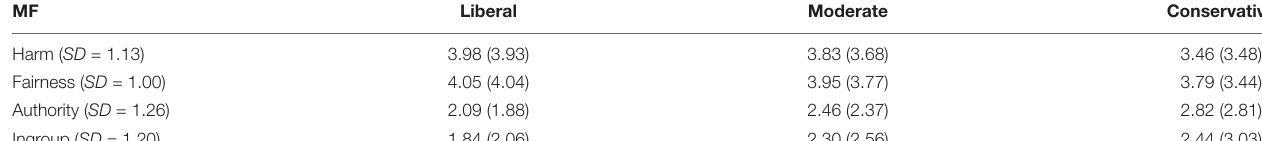
N covid indicates the number of participants who completed the COVID-19 specific block of items at time 2. TABLE 2 | Mean relevance scores for different moral foundations among liberals, moderates, and conservatives, with corresponding mean values from Graham et al. (2011) within parentheses. MF Liberal Moderate Conservative Harm ( SD = 1.13) Authority ( SD = 1.26)